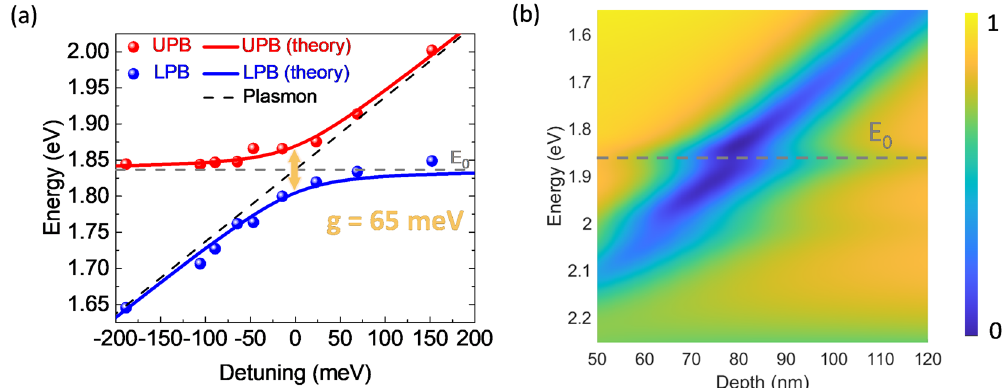
Fig. 3 Rabi splitting in hybrid systems of MoS 2 and Au NG arrays ’ hybrid system. a Dispersion of plexciton with UPB and LPB varied as functions of detuning. The dots correspond to the extract experimental data and the solid lines to the calculation results obtained using a coupled-oscillator model. The black dashed line represents the plasmon energy of the pure plasmonic cavity, and the gray dashed line indicates the excitons of the MoS 2 monolayers. The yellow arrow represents the Rabi splitting energy of this hybrid system, where the splitting energy is approximately 65 meV. b Simulated 2D contour plot of the re fl ectance for various NG depths. The gray dashed line represents the exciton